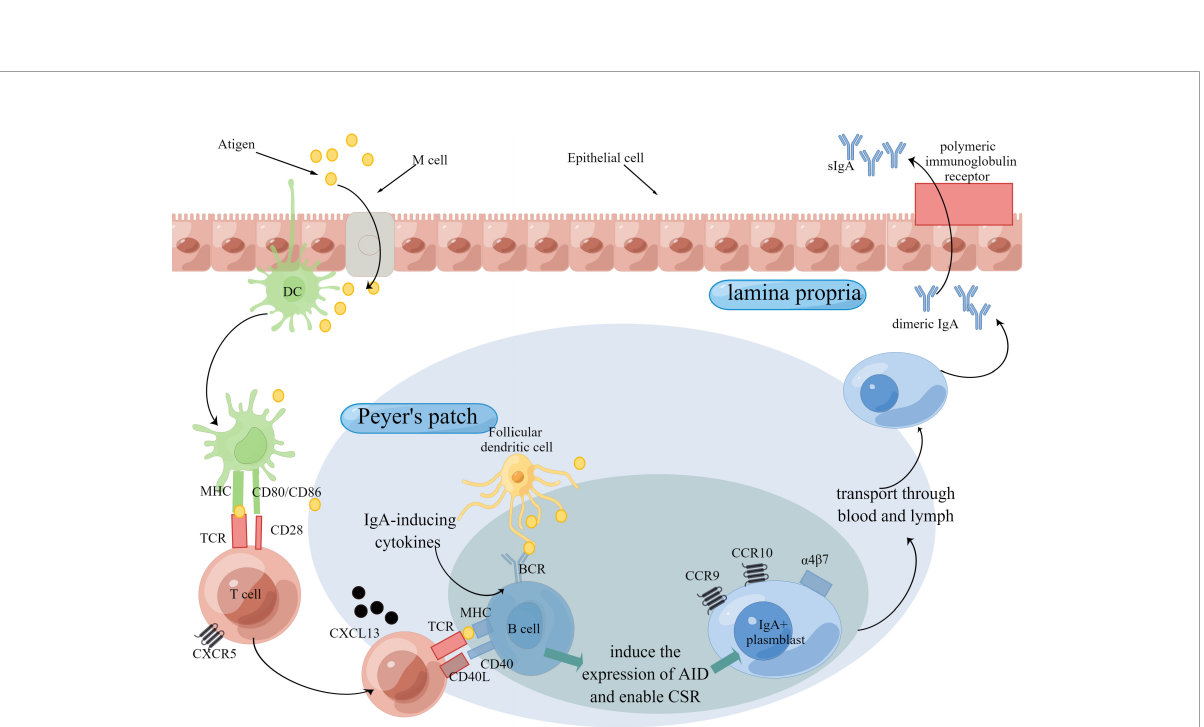
FIGURE 2 Production of IgA Through T cell-dependent Pathway. The intestinal mucosal immune function is mainly organized by the induction sites and effector sites. Peyer ’ s patch is the major induction site of immune responses. Antigens are delivered to Peyer ’ s patch by M cells and then may be captured and presented by DCs. In T cell-dependent pathway, B cells is stimulated by T cells, which release IgA-inducing cytokines, and then express CD40 ligand (CD40L) and cytokines that induce the expression of activation-induced cytidine deaminase (AID) and thereby enable class-switch recombination (CSR). After that, IgA + plasmblast is transported to effector sites, such as lamina propria. Aging is detrimental to the production of IgA for the reason that aging adversely in fl uences the number or/and function of immune cells as well as immune molecules. Abbreviations: TCR, T cell receptors; BCR, B cell